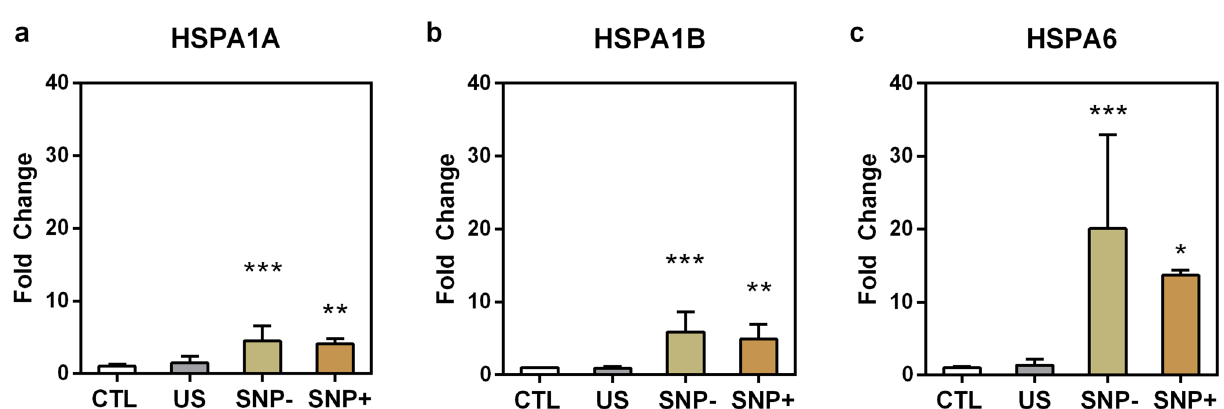
Figure 5. Messenger ribonucleic acid (mRNA) expressions of three genes in the heat shock protein-70 (HSP- 70) family for four sorted cell groups (SNP+, SNP–, US, CTL) at 3h after exposure. Fold changes relative to the CTL group are shown for: (a) HSPA1A; (b) HSPA1B; (c) HSPA6. Error bars denote standard deviation ( N =6) (*, **, and *** respectively denote p < 0.05, p < 0.01, and p < 0.001 versus CTL